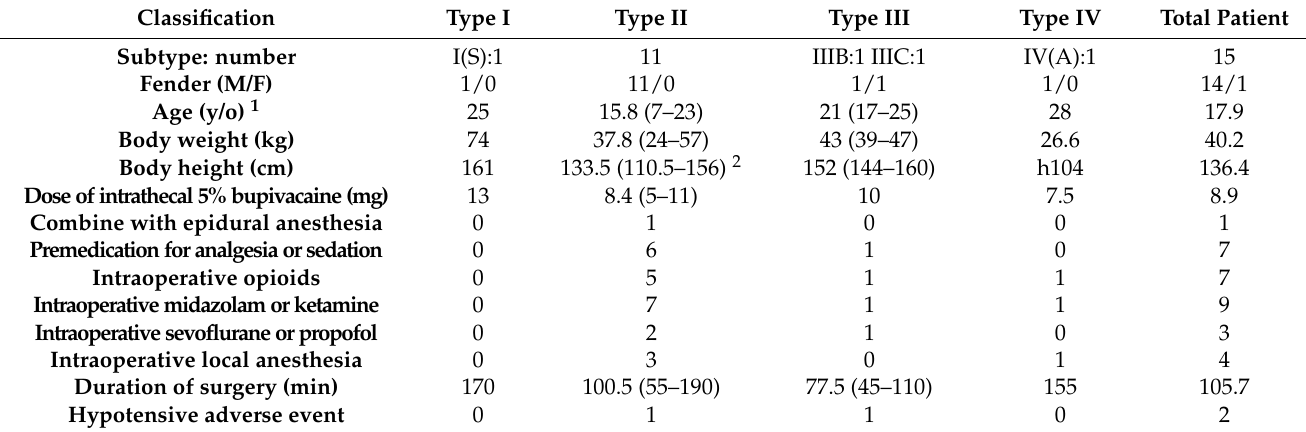
Table 3. Neuraxial anesthesia: general data, details of spinal anesthesia, and hypotensive